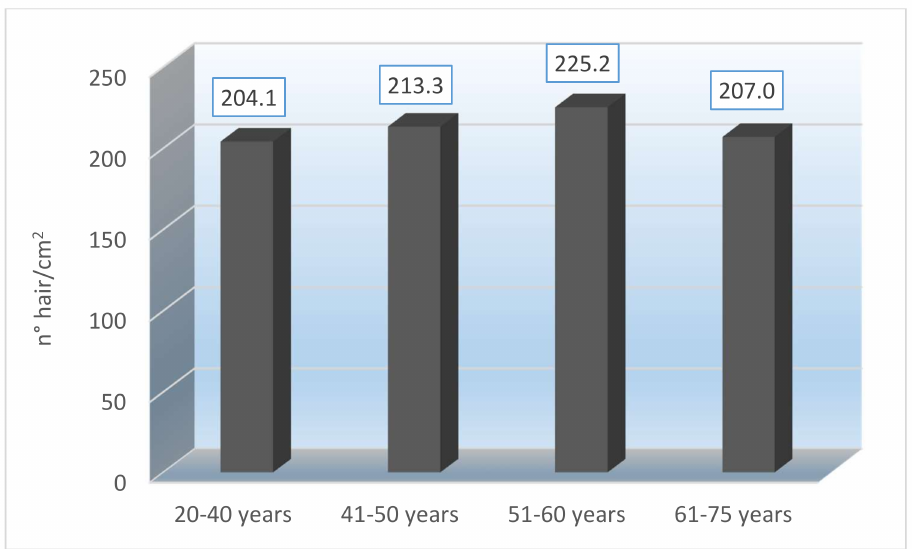
Figure 2. Mean basal values of hair density as a function of the age group.